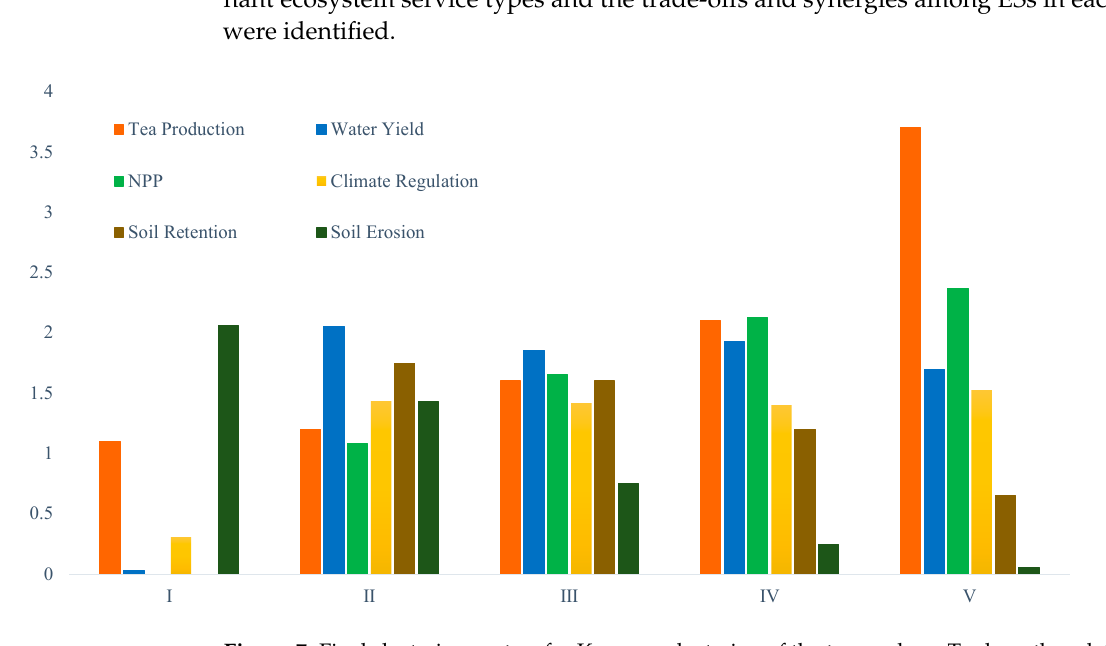
Figure 7. Final clustering centers for K-means clustering of the tea gardens. To show the relationship of the ESs, we scaled the ESs in the same dimension so that they can be displayed in the same field of view. Table 6. Statistics of the tea garden ES partitions in Fuzhou.